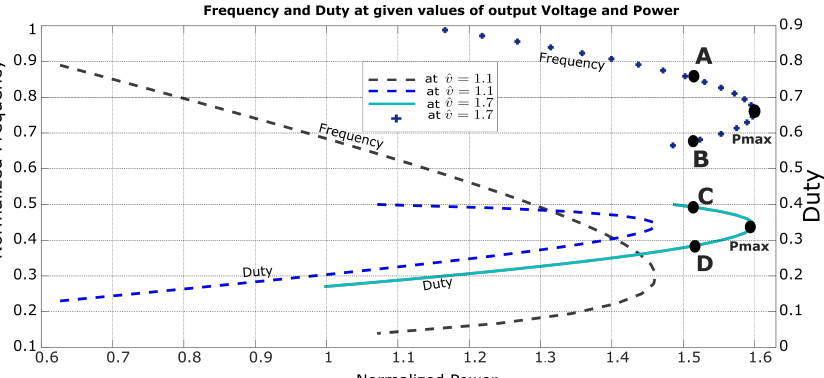
Figure 6. Illustration of normalized frequency vs. normalized power and duty vs. normalized power in presence of normalized voltage with the related behaviors. A and B show the point of same power on a value of frequency, while C and D show the point of same power on a value duty.